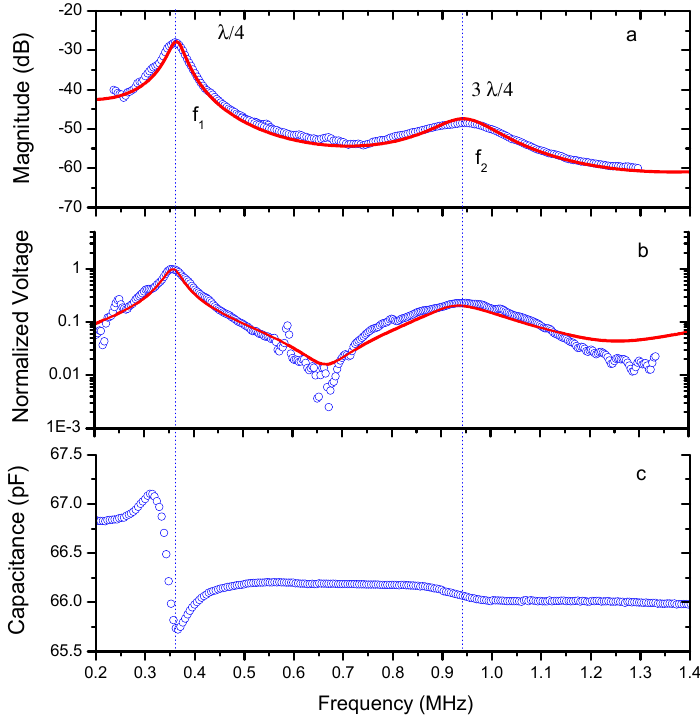
Figure 7. Measured (circles) and calculated (solid line) response vs . frequency of the PP film with a double adhesive electrically conductive layer glued to one surface. ( a ) Magnitude of transmission coefficient. ( b ) Normalized electrical voltage across the film generated by the incident acoustic beam. ( c ) Electrical